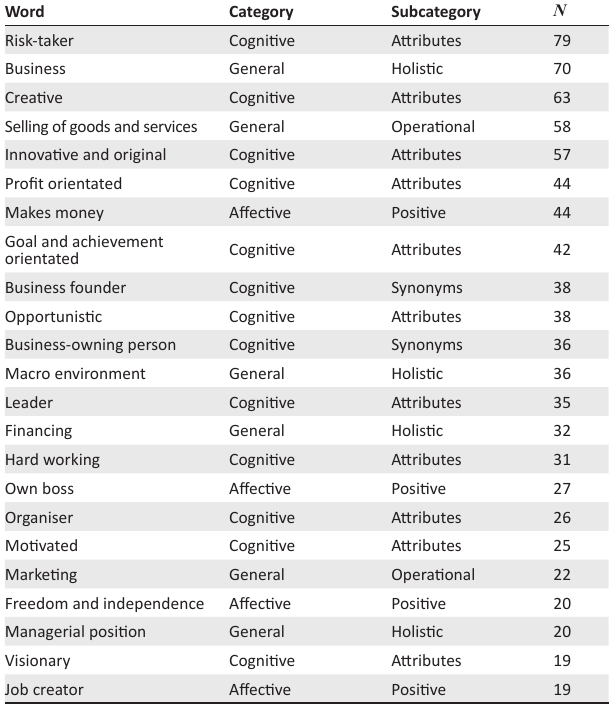
TABLE 4: Most frequently recurring words ( n =